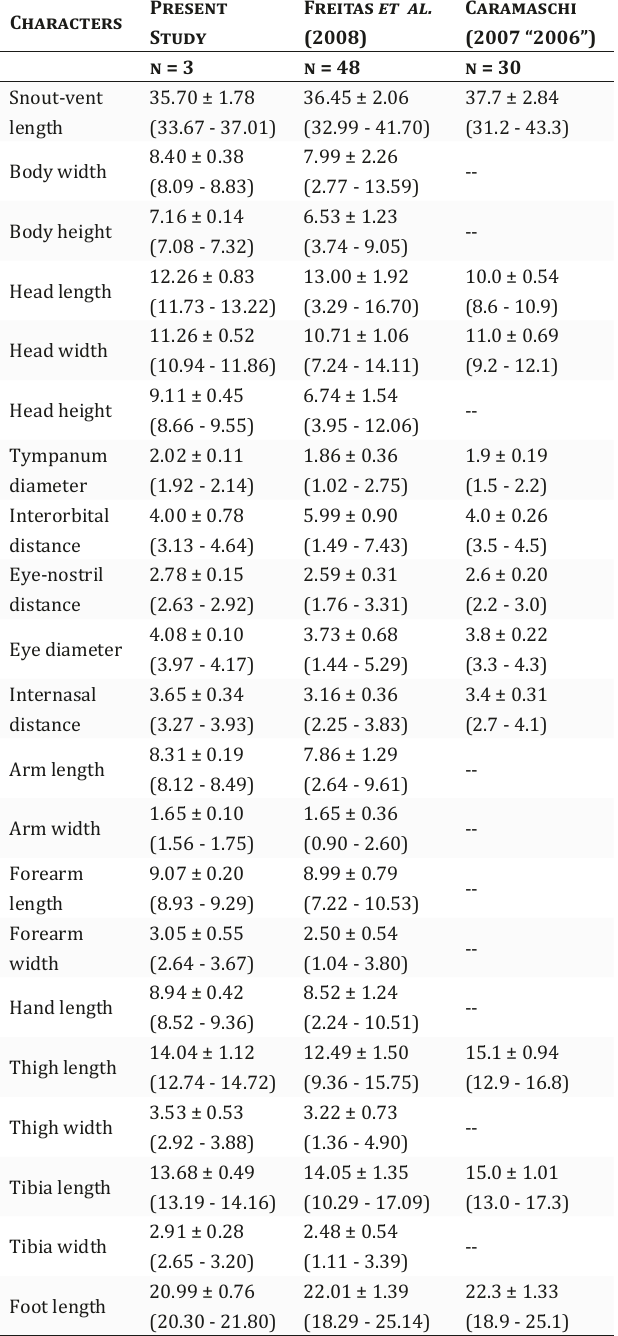
Table 1 . Phyllomedusa azurea Morphometric measurements of the tree collected males of in the municipality of Água Doce, state of Santa Catarina, Brazil, and measurements of males reported by